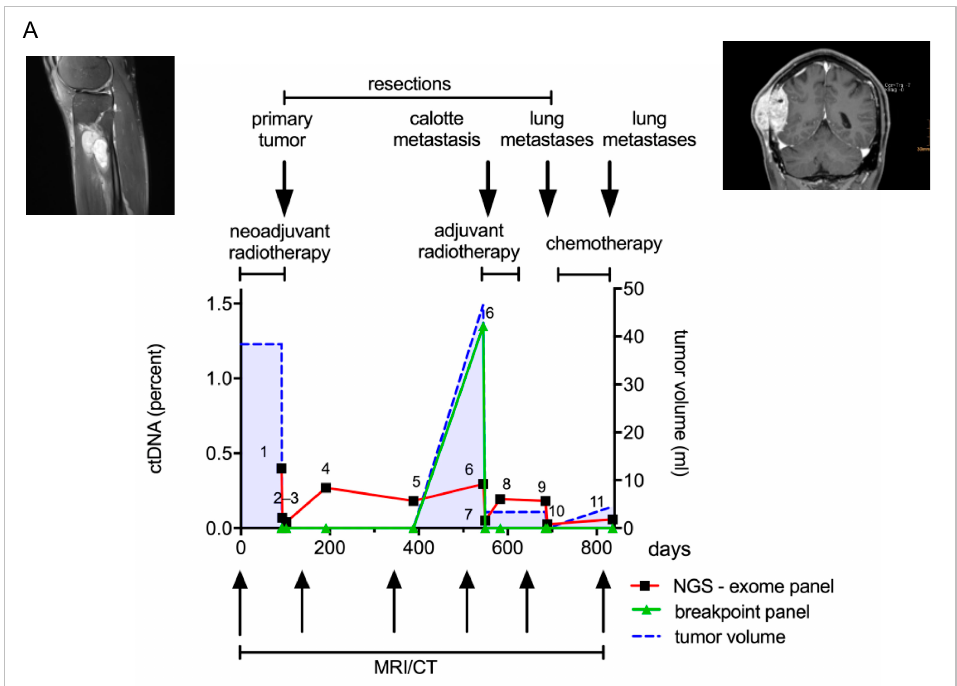
B Figure 4. Cont